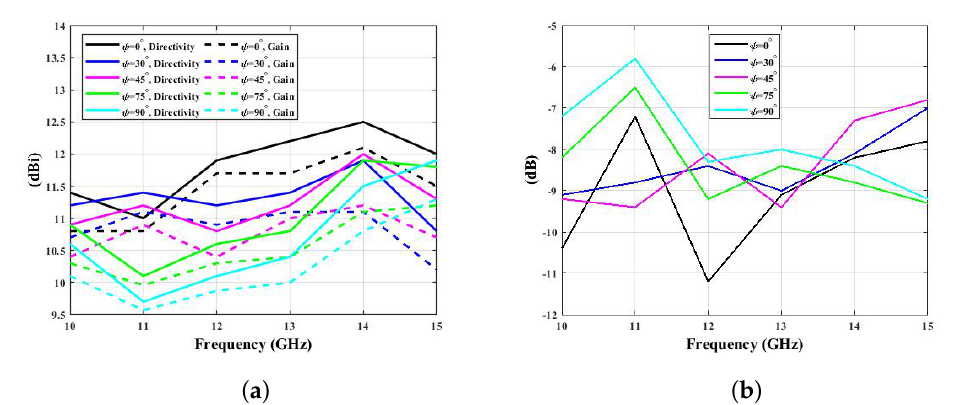
Figure 9. ( a ) Distribution of simulated peak directivity and gain values. ( b ) Side lobe levels plot in 10 GHz, 11 GHz, 12 GHz, 13 GHz, 14 GHz and 15 GHz frequencies.